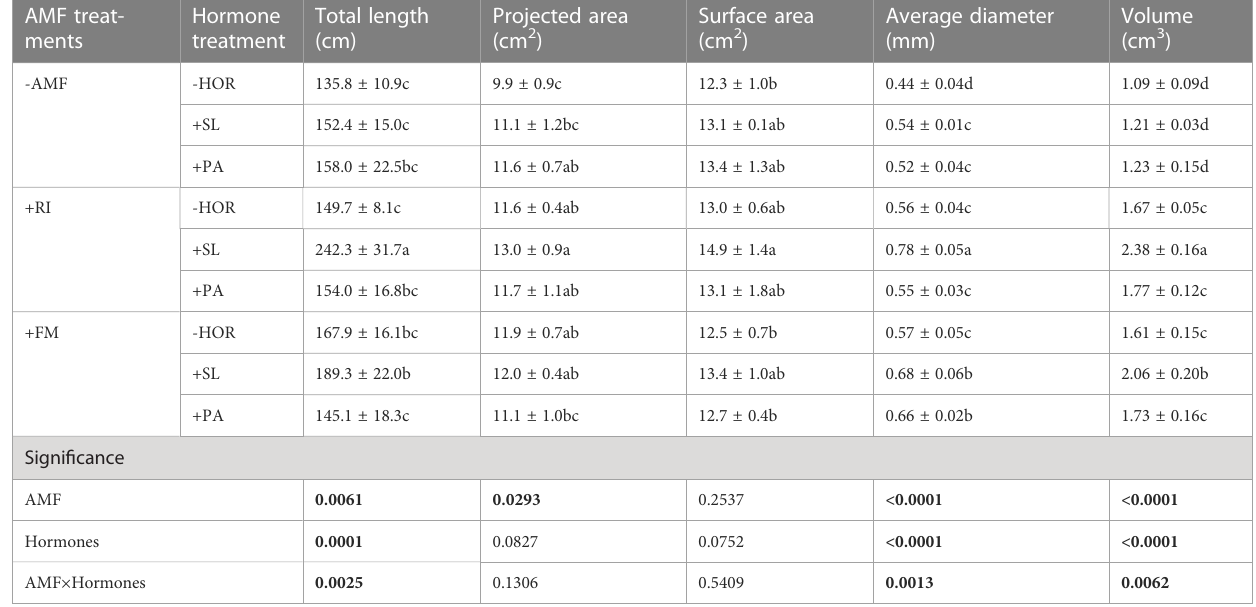
TABLE 3 Interaction effect of AMFs and hormones on the root system architecture of tea cutting seedings.